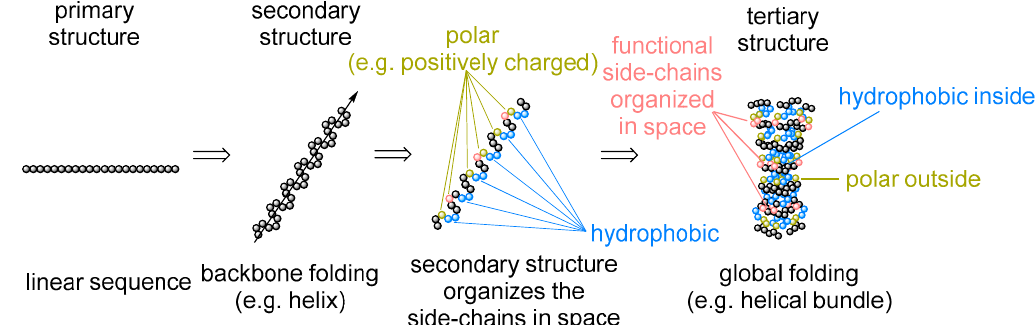
Figure 1. The hierarchy of protein folding.